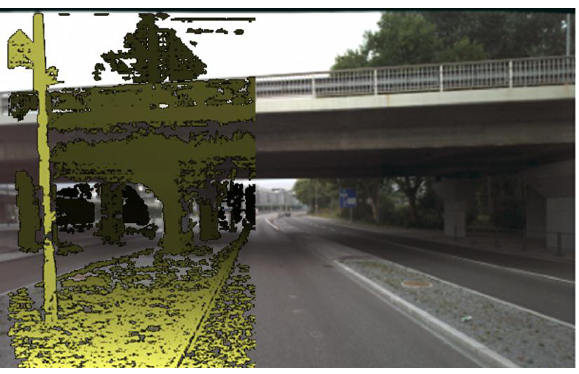
Figure 7. Left stereo normal image with overlaid dense depth map (shown in left half of the image) An initial accuracy evaluation of the extracted 3d point clouds was performed by using four planar patches on the road surface Figure 6. Mono client with ground-based imagery, and overlaid as reference surfaces. These test areas were extracted from the 3d vector data (left), map interface (bottom right) and feature editor (top right)